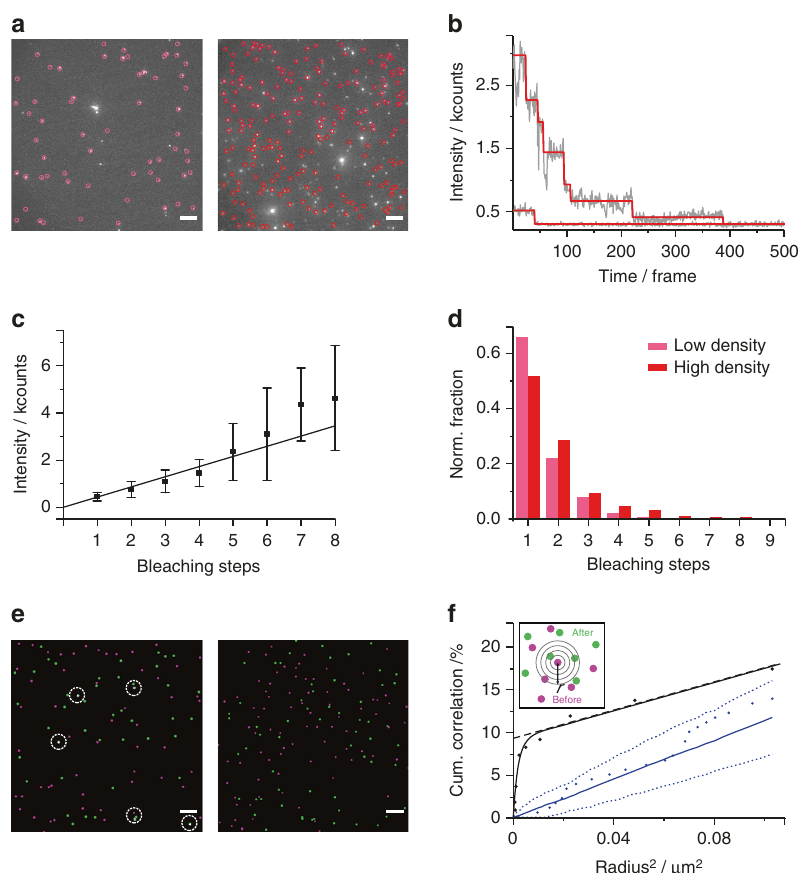
Fig. 4 Dynamic clustering of AF647 NP3-C explored by photobleaching analysis. a Photobleaching analysis at low (left: 0.47 µ m − 2 ) and high (right: 1.94 µ m − 2 ) densities of immobile AF647 NP-3C inserted into DOPC PSM. Signals that were detected and used for the analysis are encircled. Scale bars: 5 µ m. b Typical intensity traces of individual signals showing single or multi-step intensity decays by photobleaching with an overlay of the STaSI trace shown in red. c Correlation of the intensity of localized signals in the fi rst frame against the number of detected bleaching steps by the STaSI algorithm ( n = 10, mean and s.d.). d Histogram of bleaching steps for low and high densities. The data in c and d relies on analyzing n = 5822 clusters at high density and 1397 clusters at low density. e , f Spatial correlation of AF647 NP-3C clusters explored by fl uorescence recovery after photobleaching (FRAP) and particle image cross-correlation spectroscopy (PICCS). e Left: Localized immobile AF647 NP-3C clusters before (magenta) and 15 min after (green) complete photobleaching of the shown area. AF647 NP-3C clusters co-localizing in both images are highlighted by white circles. Right: negative control showing the overlay of immobile AF647 NP-3C signals from two separate, uncorrelated areas. Scale bars: 5 µ m. f PICCS analysis of clusters localized before and after photobleaching (black) and the negative control (blue solid line) including the boundaries of a 95% con fi dence interval (blue dotted lines). The intercept of the linear contribution to the curve (black dashed line) corresponds to the correlated fraction α . The concept of PICCS is graphically depicted in the